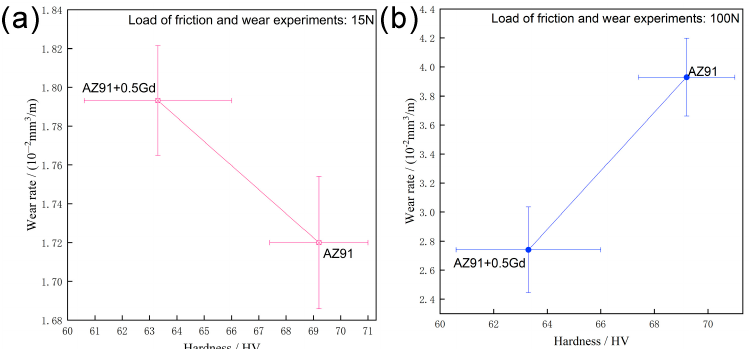
Figure 11. Relationship between hardness and wear rate of surfacing magnesium alloys under different friction loads: ( a ) 15N, ( b ) 100N.